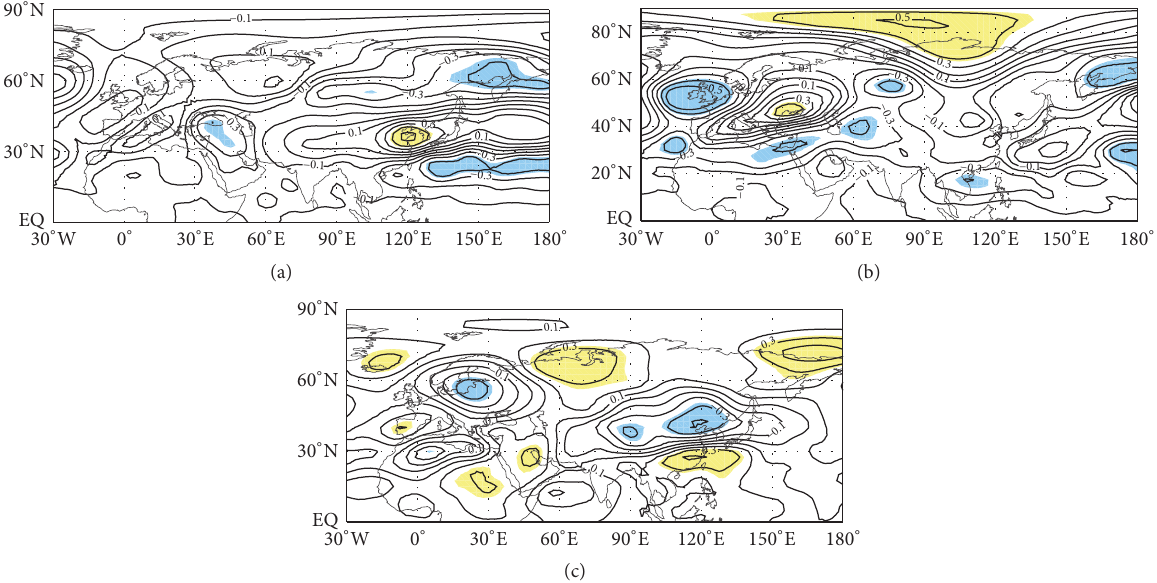
Figure 5: The correlation maps between PCs time series of coefficients and summer 500 hPa geopotential height (GPH) for the periods 1961– 1979 and 1980–2013. (a) PC1 for 1961–1979, (b) PC2 for 1961–1979, and (c) PC2 for 1980–2013. The shading (yellow for positive correlation and blue for negative correlation) exceeds 90% confidence level based on a two-tailed Student’s 𝑡 - test.